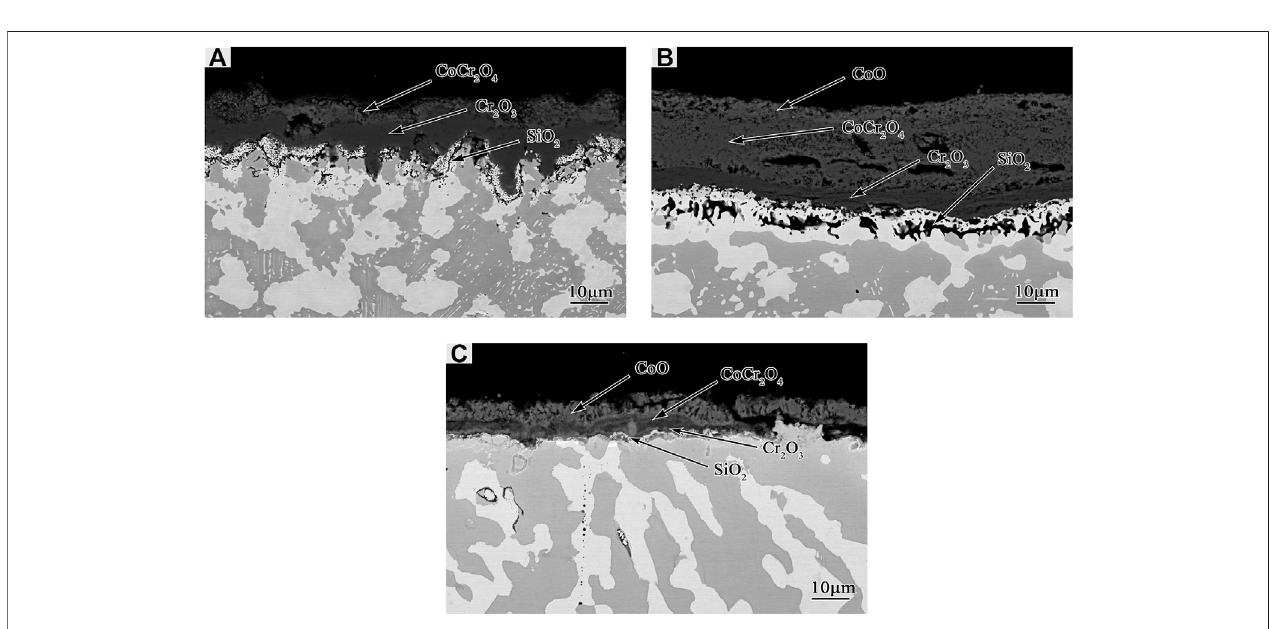
FIGURE 7 | Cross-sectional micrographs of Co-20Re-25Cr-3Si alloys oxidized under 0.1 MPa laboratory air for 24 h: (A) 1,000 ° C; (B) 1,100 ° C; (C) 1,200 ° C.